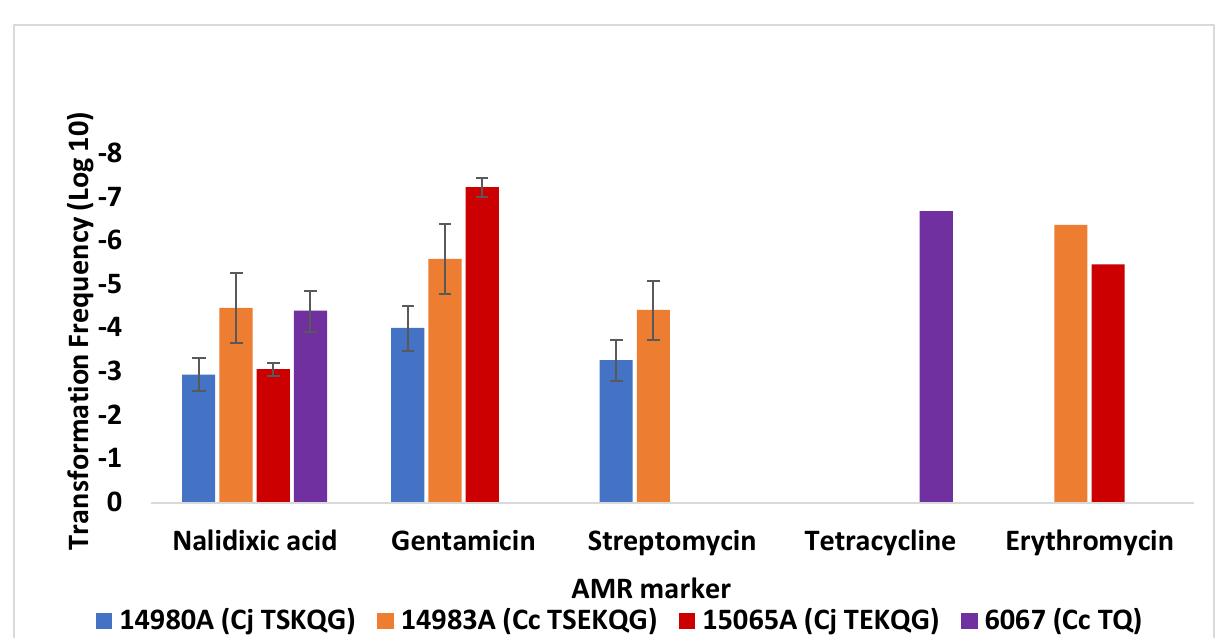
Figure 4. Transformation of C. jejuni FSIS 18110577 with DNA from a panel of C. jejuni and C. coli donors. Transformation frequencies are averages from two or more independent trials for each recipient strain–donor DNA pair, and transformations were carried out as described in Materials and Methods. Cj and Cc in front of strain designations indicate C. jejuni and C. coli , respectively. AMR phenotype designations in strain names are as in the legend to Figure 2. The error bars on the columns with the transformation frequency data for tetracycline and erythromycin resistance were too small to be visible.